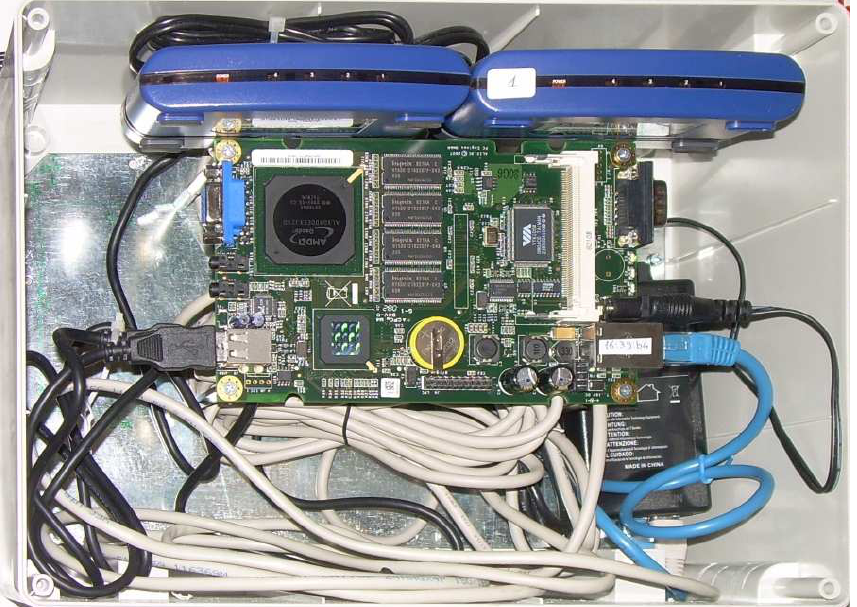
Figure 2. An example of Node Cluster Gateway (NCG), showing the embedded computer in the center, and the two USB 2.0-compliant hubs at the